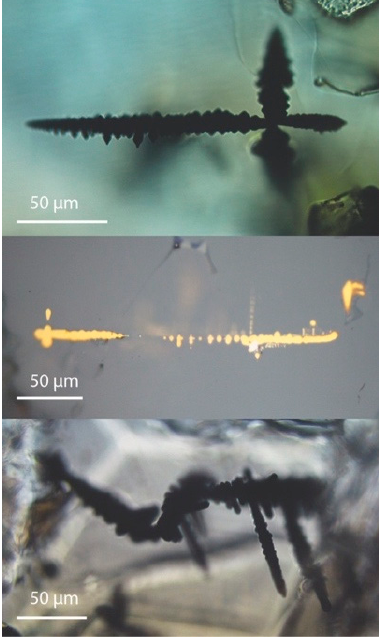
Figure 2. Microscope images of Ti nitride filling skeletal cavities in corundum. ( upper and lower panels ) Transmitted light; ( middle panel ) reflected light.